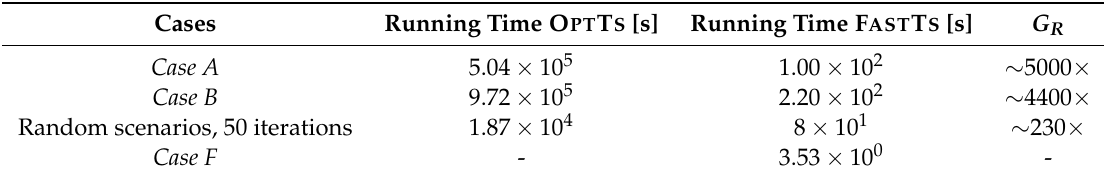
Table 9. Average running time in small-scale